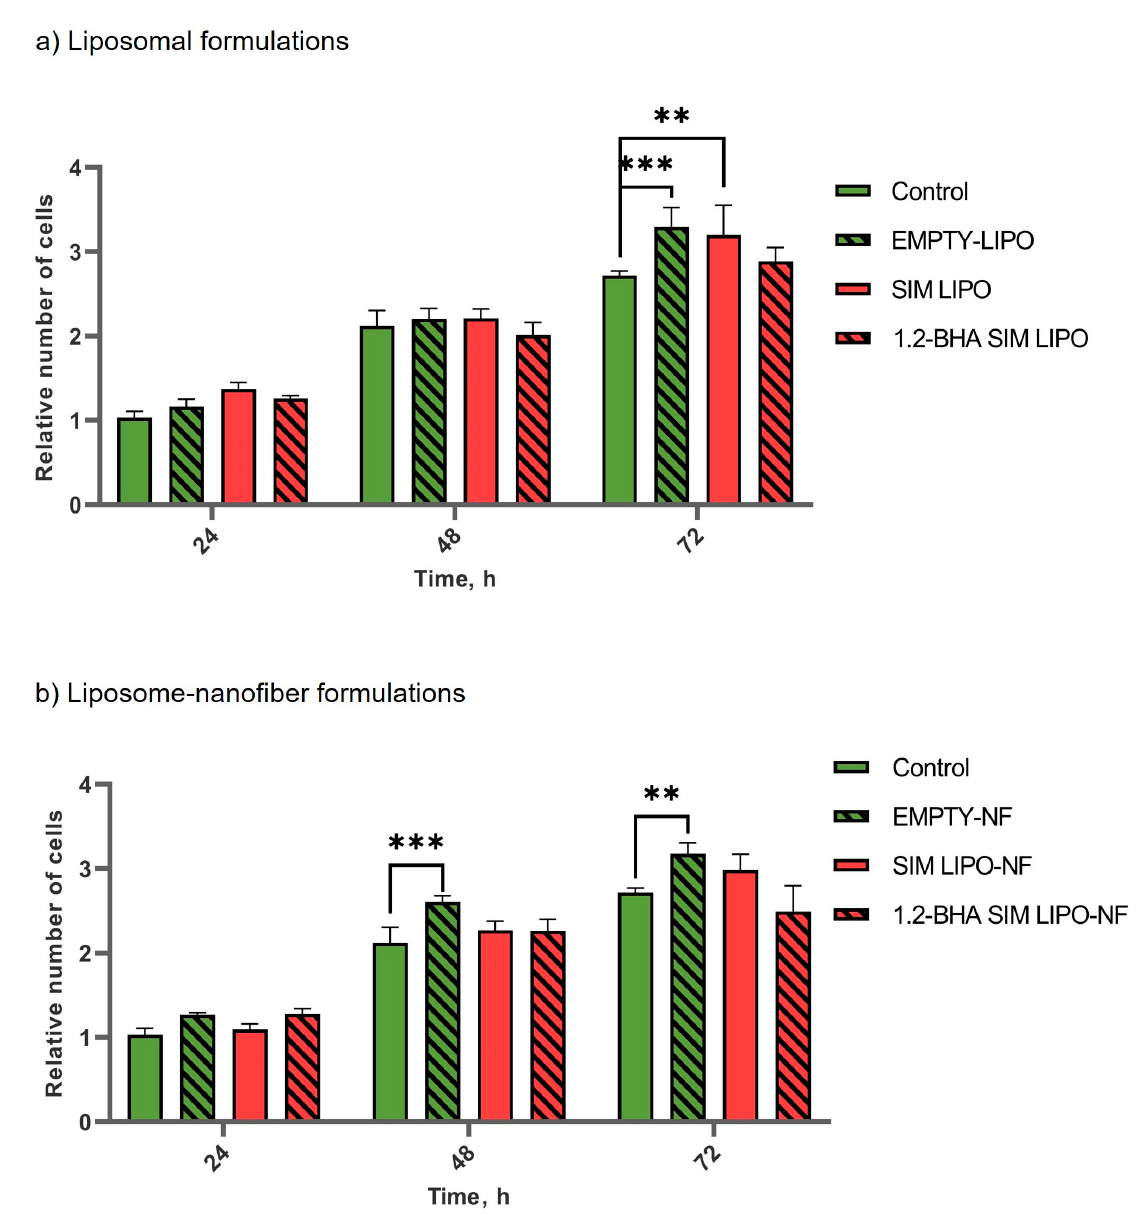
Figure 8. The effects of ( a ) liposomal formulations and ( b ) composite liposomal-nanofiber formula- tions on keratinocyte proliferation. Data are presented as means ± SD ( n = 3). ** p < 0.01, *** p < 0.001.